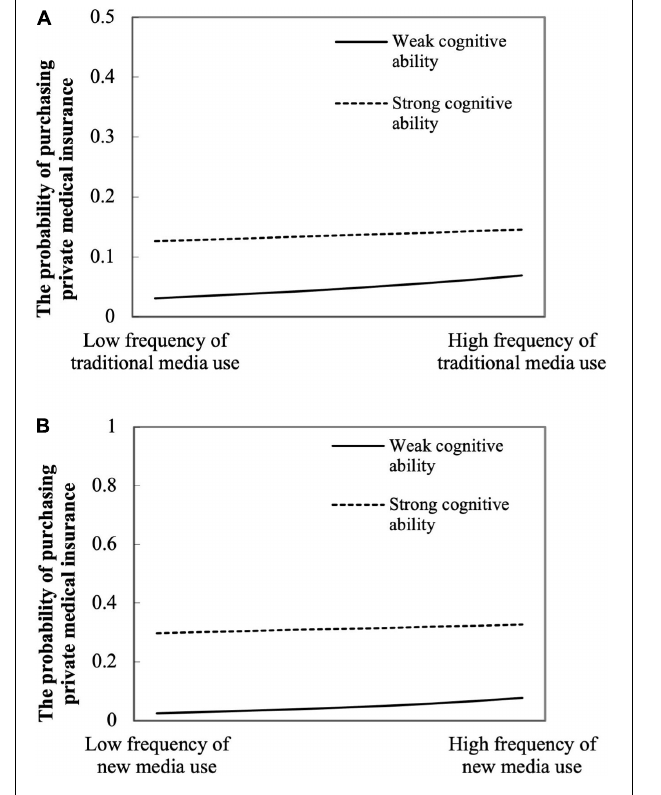
FIGURE 2 | Moderating effect of cognitive ability on media use on the probability of purchasing private medical insurance. (A) Traditional media use; (B) new media use.